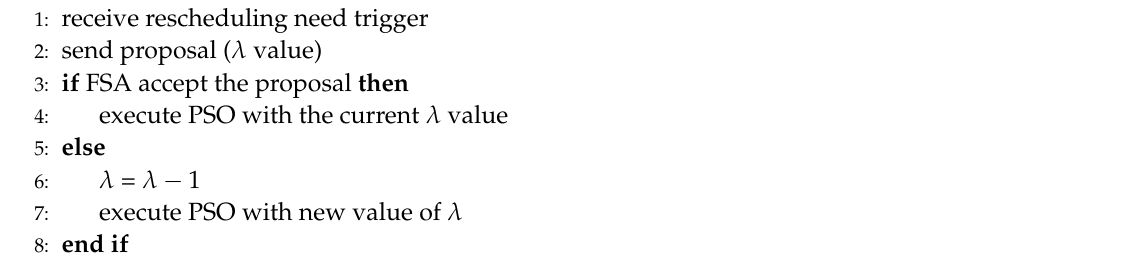
Algorithm 3 Pseudo code of negotiation protocol between factory scheduler agents